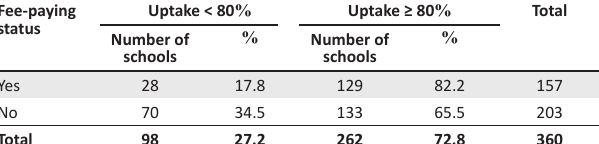
TABLE 3: Tshwane’s sub-district VUR stratified by the school’s fee-paying